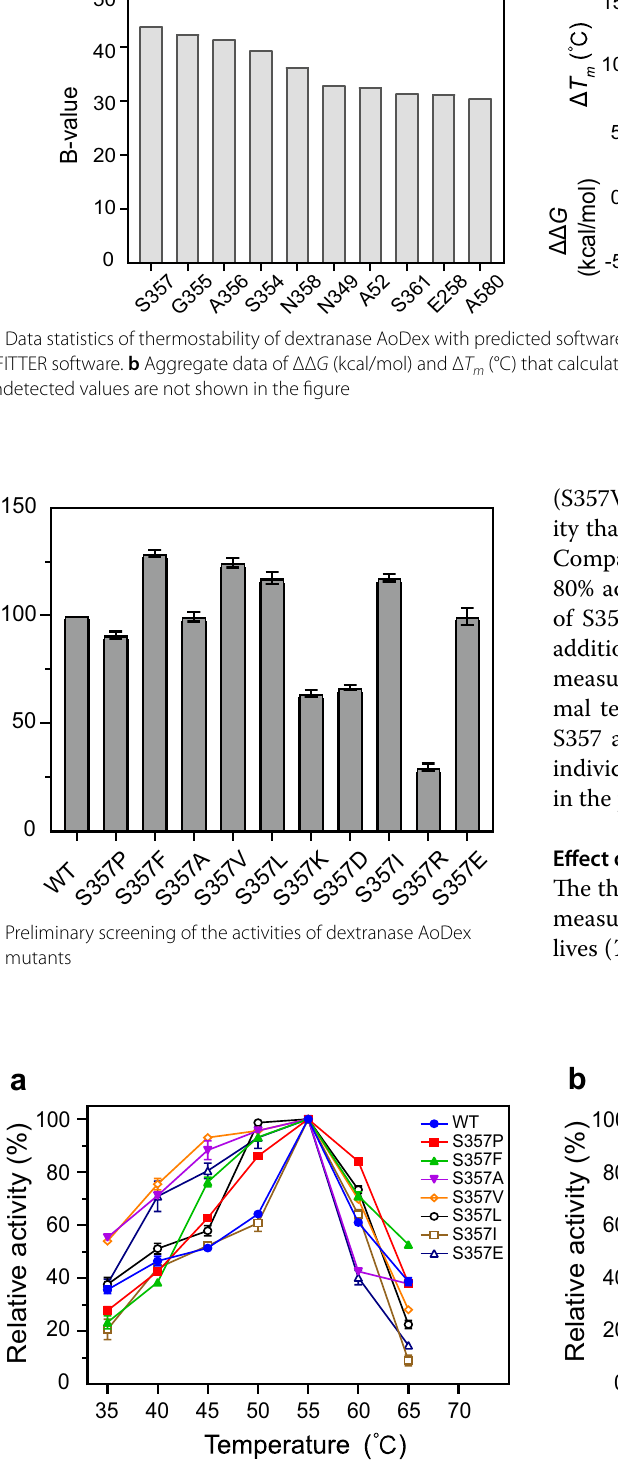
Fig. 3 Enzymatic properties of dextranase AoDex and its mutants. Relative activity is defined as the percentage of maximum enzymatic activity under the corresponding experimental conditions. a The optimal temperature of AoDex and mutants. The activities were determined at pH 7.0. b The optimal pH of AoDex and mutants. The activities were determined at 55